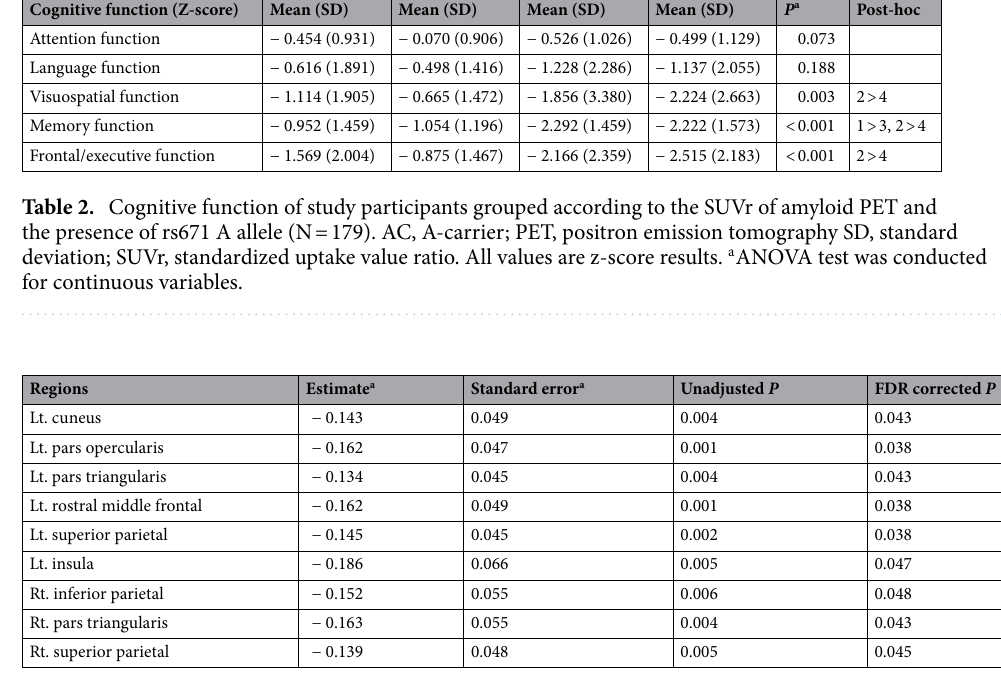
Table 3. Results of regressions analyses of the interaction effect of amyloid deposition and rs671 polymorphism on brain cortical thickness, only showing significant regions. FDR, false discovery rate; APOE, apolipoprotein E; CDR, clinical dementia rating. Adjusted for age, sex, education year, total intracranial volume, APOE-ε4 carrier status, lifetime drinking status, Framingham general cardiovascular risk score, CDR sum of box, white matter hyperintensity score of peripheral and deep white matter. a Values from amyloid deposition and rs671 polymorphism interaction term in multiple regression model.